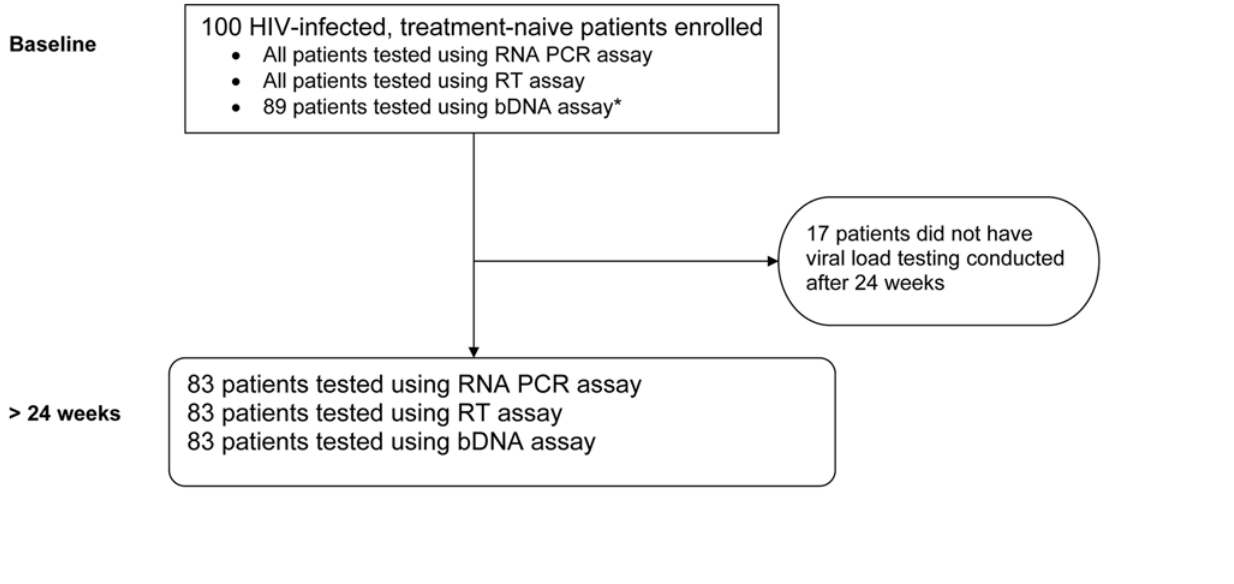
Figure 1. Flow chart of subjects with HIV viral loads conducted at baseline and follow-up after 24 weeks of antiretroviral therapy. (RT=Cavidi reverse transcriptase (RT) assay, Roche RNA PCR, and bDNA=branched DNA assay).